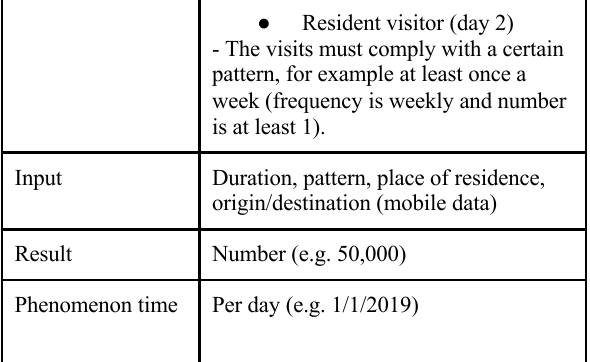
Table 3. Description of the profile “Structural day visitor”.